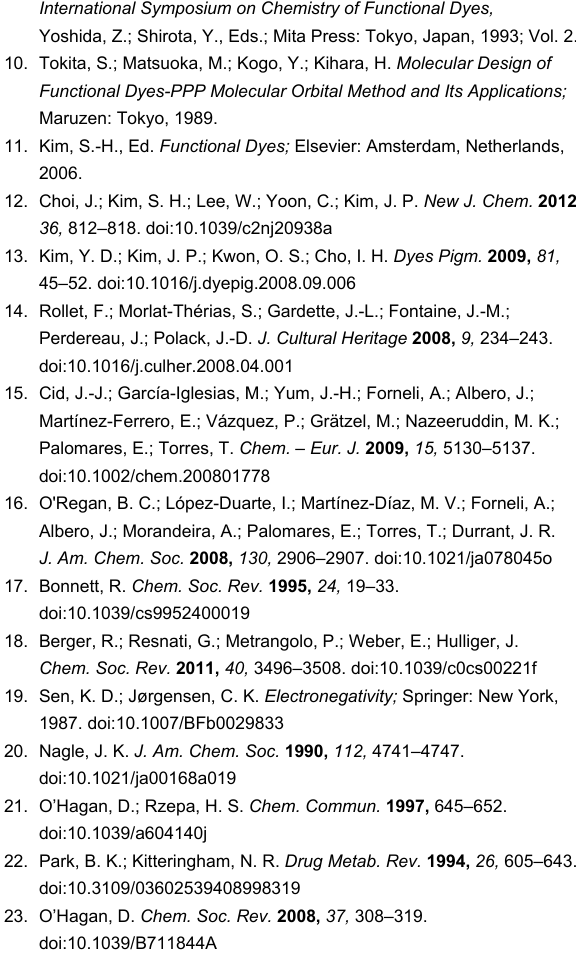
stability, high solubility and high lipophilicity. By combining the characteristics of fluorine and the functionalities of phthalo- cyanine, it is expected that new applications of phthalocyanines can be explored in